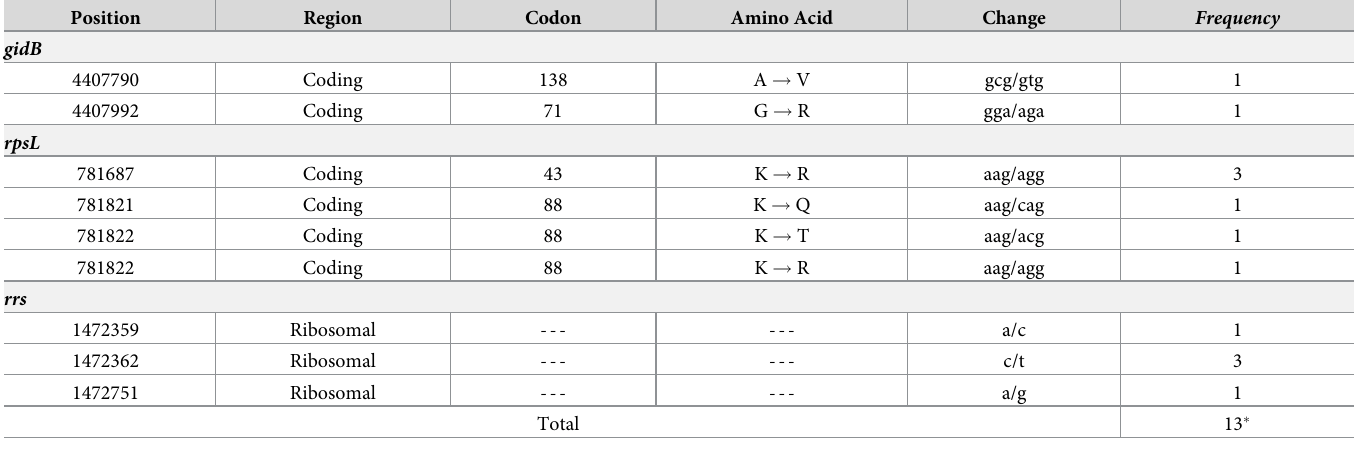
Table 5. Streptomycin mutations obtained by WGS from isolates of Mycobacterium tuberculosis circulating in Veracruz, Mexico. Position Region